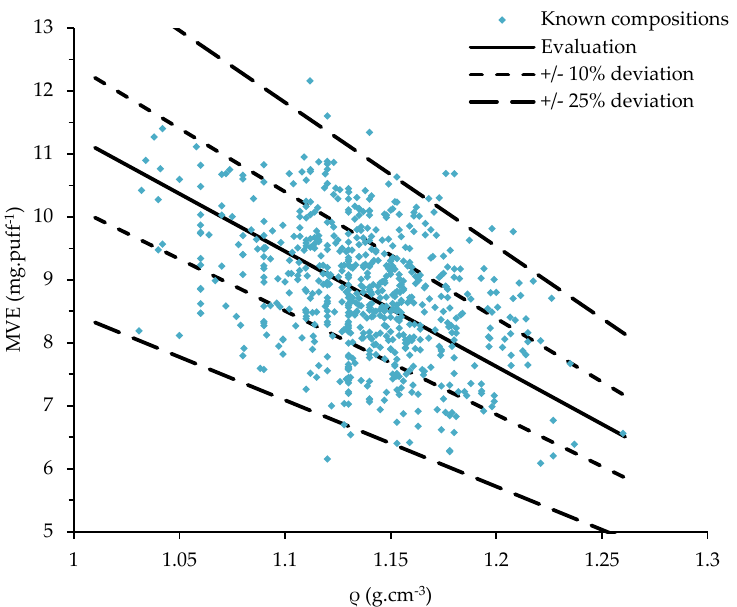
Figure 8. MVE — Distribution of the measured values for the liquids with known compositions.